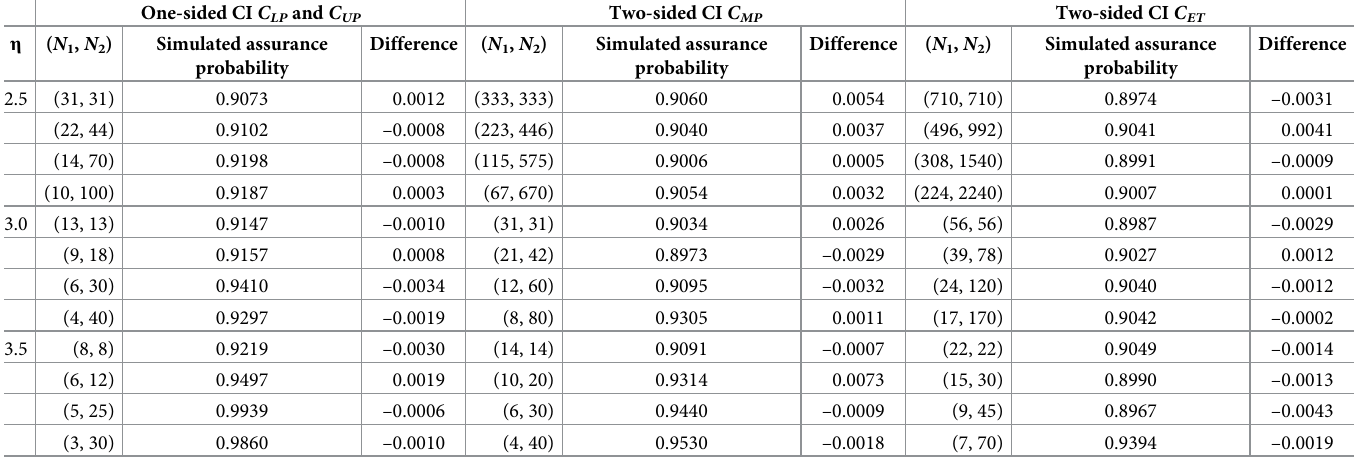
Table 5. The computed sample size, simulated assurance probability and errors for the 90% reference intervals of the distribution proportion 0.90 with assurance probability 0.90. One-sided CI C and C LP UP η ( N 1 , N 2